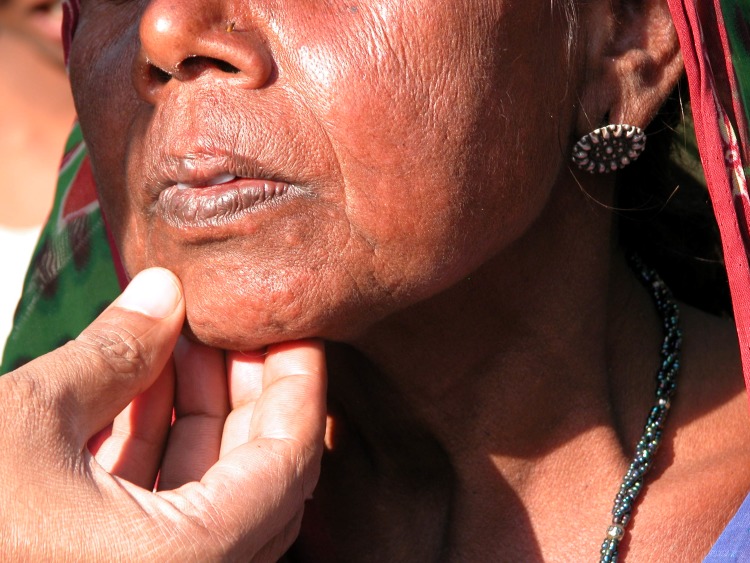
PKDL from India: discrete papules and infiltration of the chin, resulting in a plaque.PKDL, post-kala-azar dermal leishmaniasis.